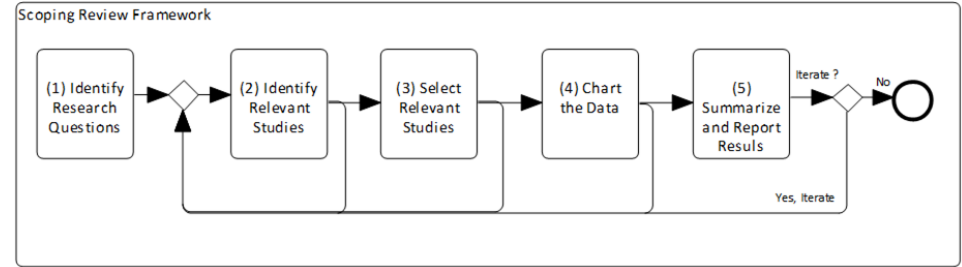
Figure 1. Followed stages of the scoping review